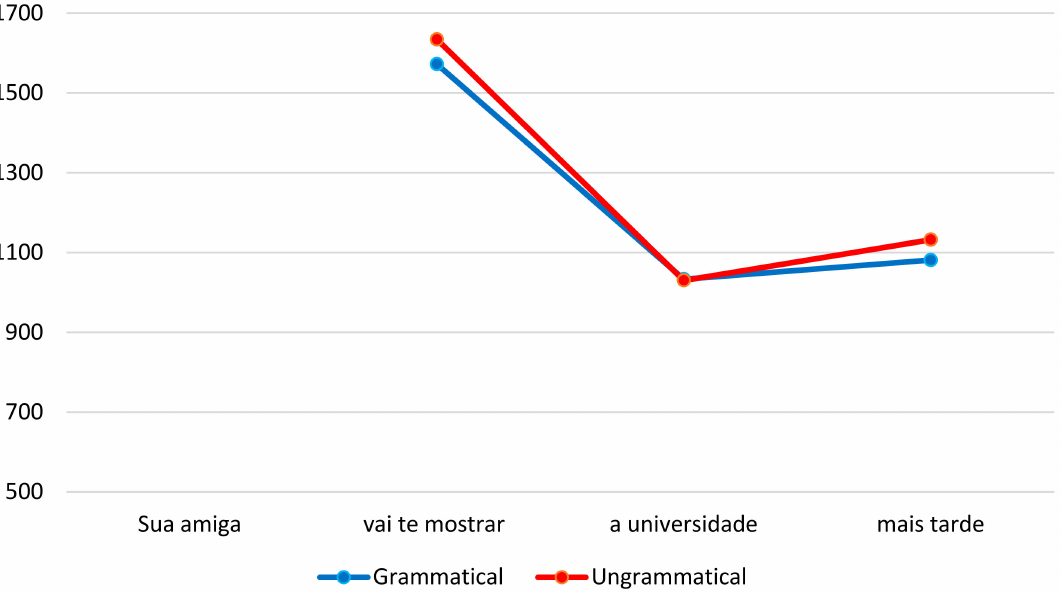
Figure 6. L1 English speakers in the restructuring